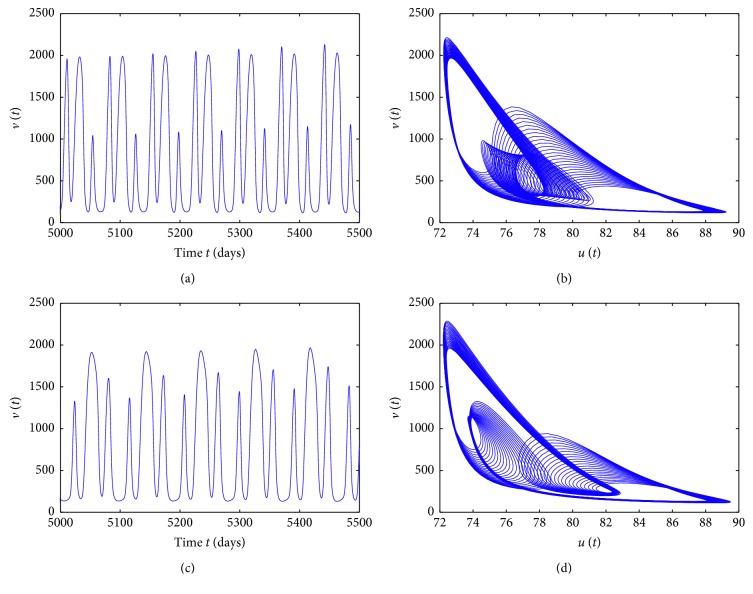
Solutions of the model for τ=35 (a, b) and τ=45 (c, d), corresponding to Figure 3(b).